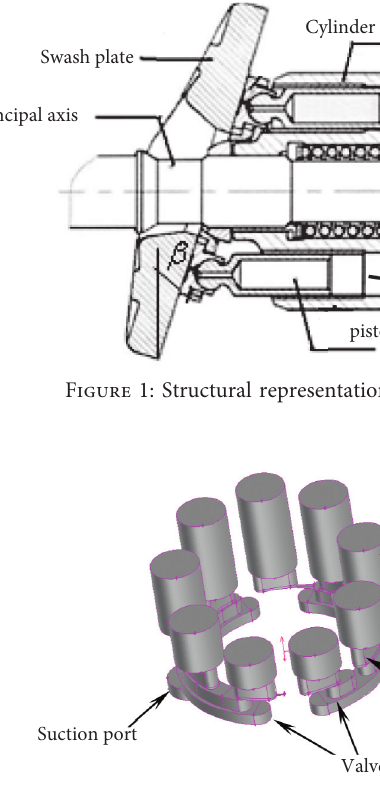
Figure 2: Internal fluid in an axial piston pump [30].